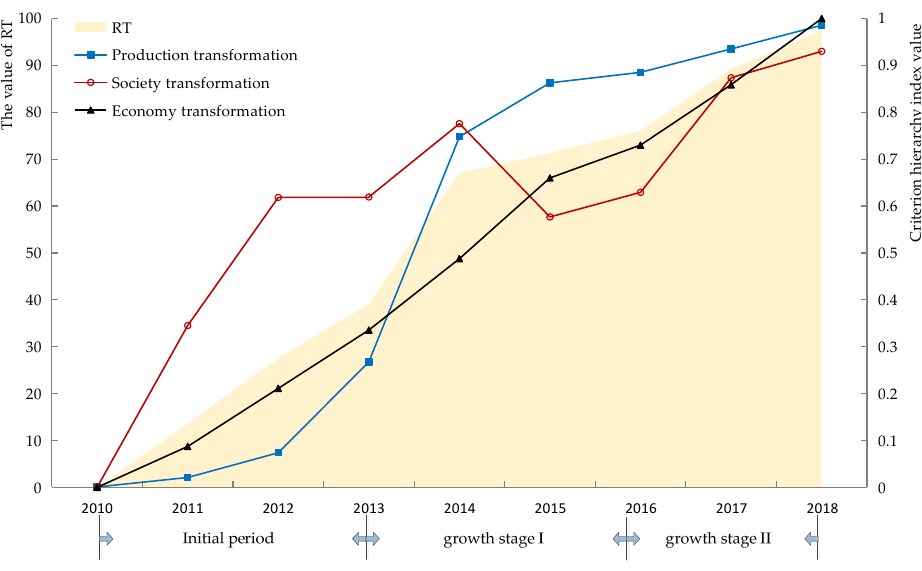
Figure 6. Level of RT in Linqing County from 2010 to 2018.